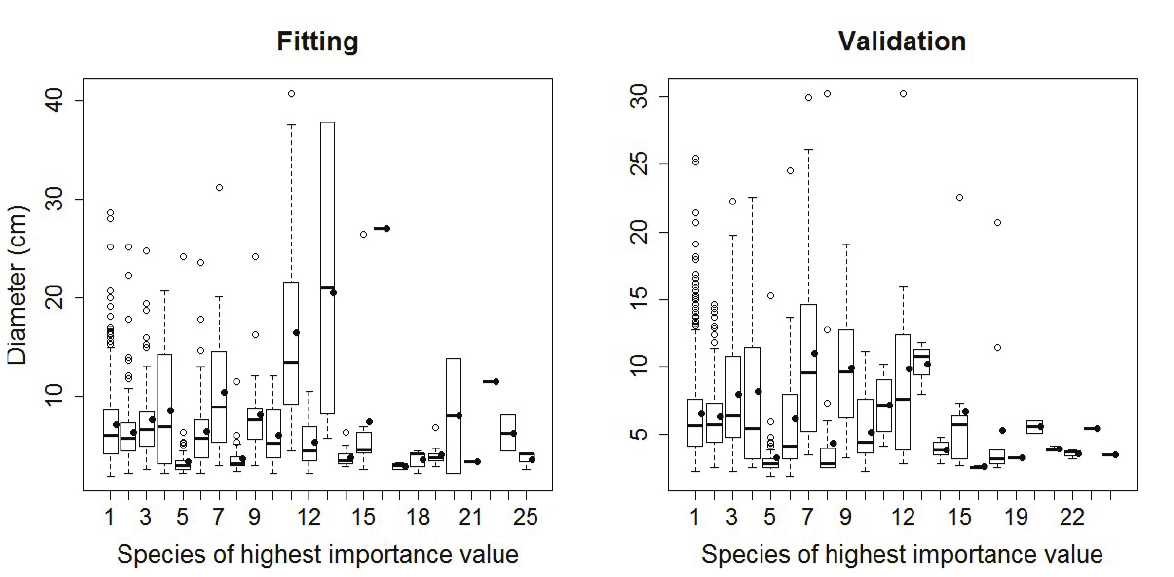
figure 2 – Box plot of the diameter and potential outliers for fit and validation database of the highest importance ( HIV ) and other species. Where: 1 = P. bracteosa ; 2 = M. ophthalmocentra ; 3 = A. pyrifolium ; 4 = M. urundeuva ; 5 = B. cheilanta . The black spots indicate the average values of the diameters for each species in their